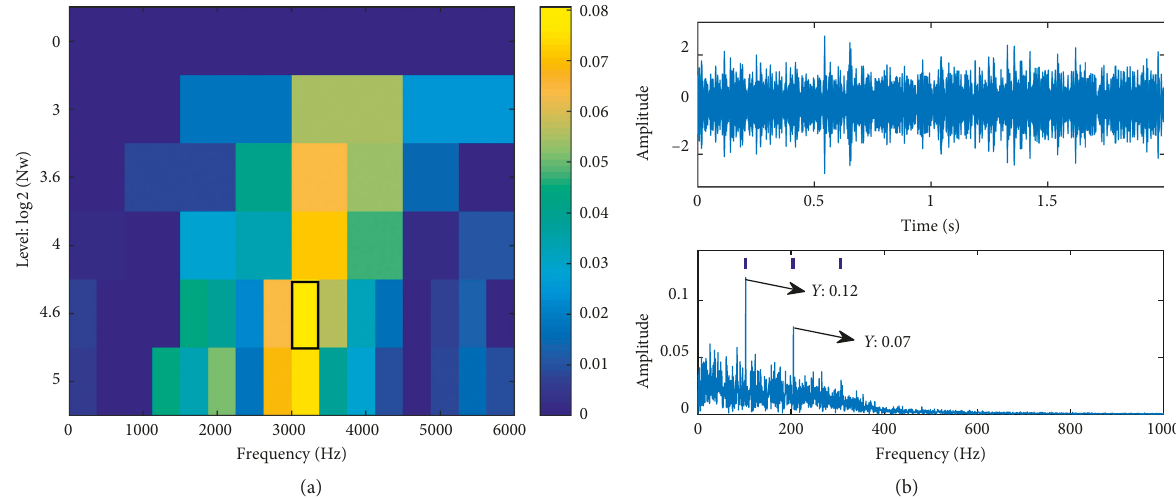
Figure 17: (a) Fast kurtogram based on STFT; (b) signal component and its envelope sequence.